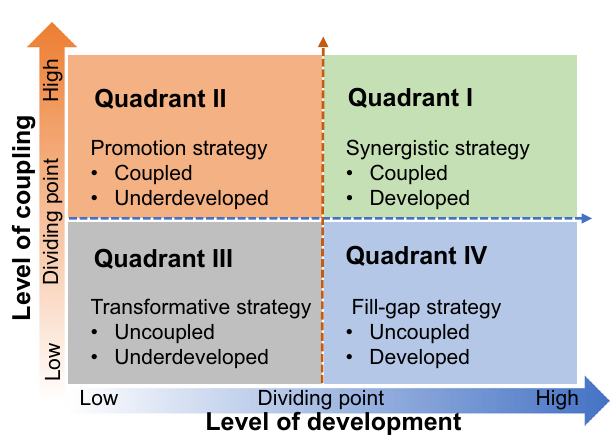
Fig. 2 | Development patterns and corresponding sustainable management strategies towards a more sustainable development direction. Four develop- ment patterns are divided based on two dimensions: level of development ( x -axis) and level of coupling ( y -axis). The level of coupling classi fi es regions according to the magnitude of coupling coordination degree between human well-being and environmental performance, whereas the level of development re fl ects changing trendsincouplingcoordinationdegreeovertime.Regionslocatedinthequadrants away from the middle horizontal line are more coupled. Regions in the quadrants far away from the middle vertical line are more developed.